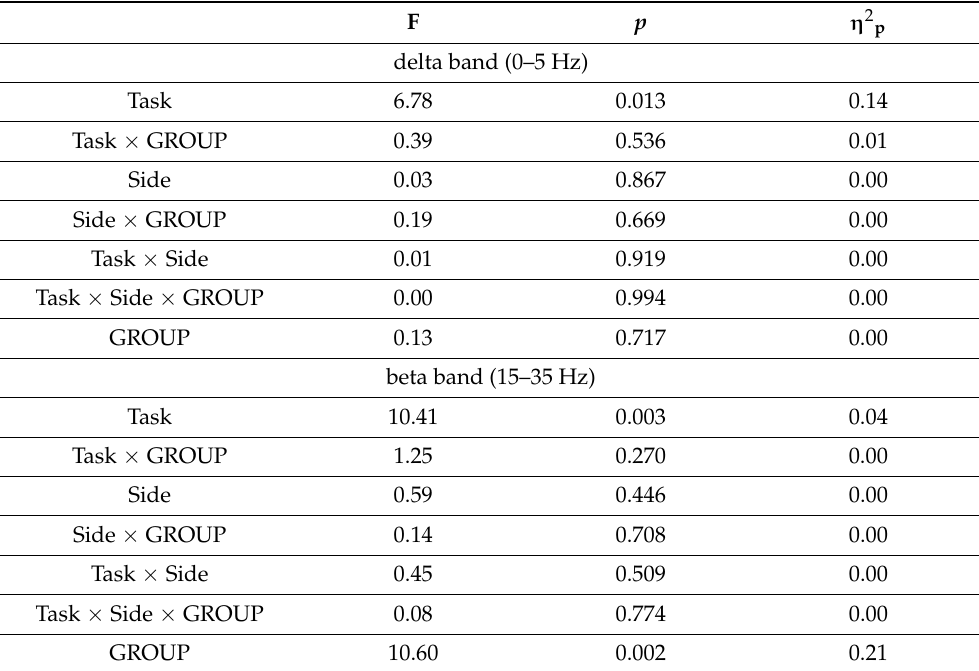
Table 1. Results of ANOVA analysis of significance of Within Subjects Effects differences in delta band (0–5 Hz) and beta band (15–35 Hz). F p η 2 p delta band (0–5 Hz)